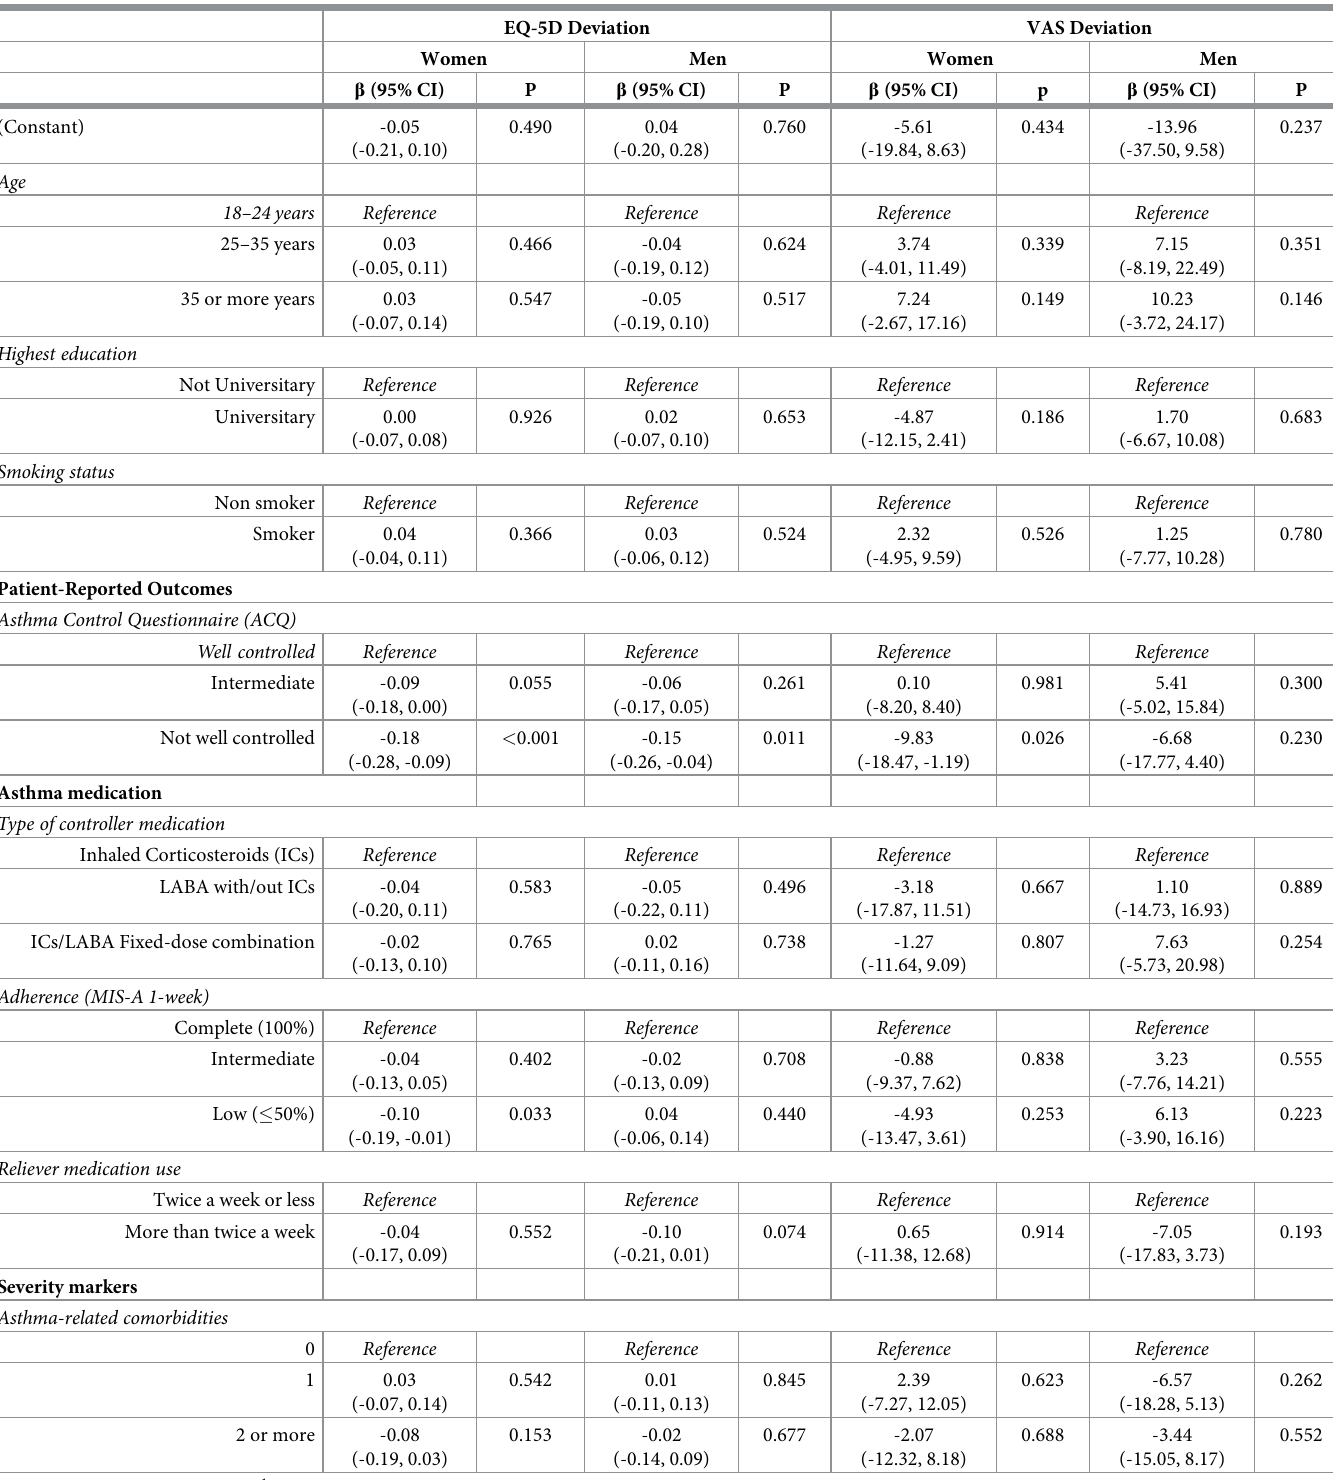
Table 3. Regression models of EQ-5D-5L and EQ-VAS deviation from norms regarding